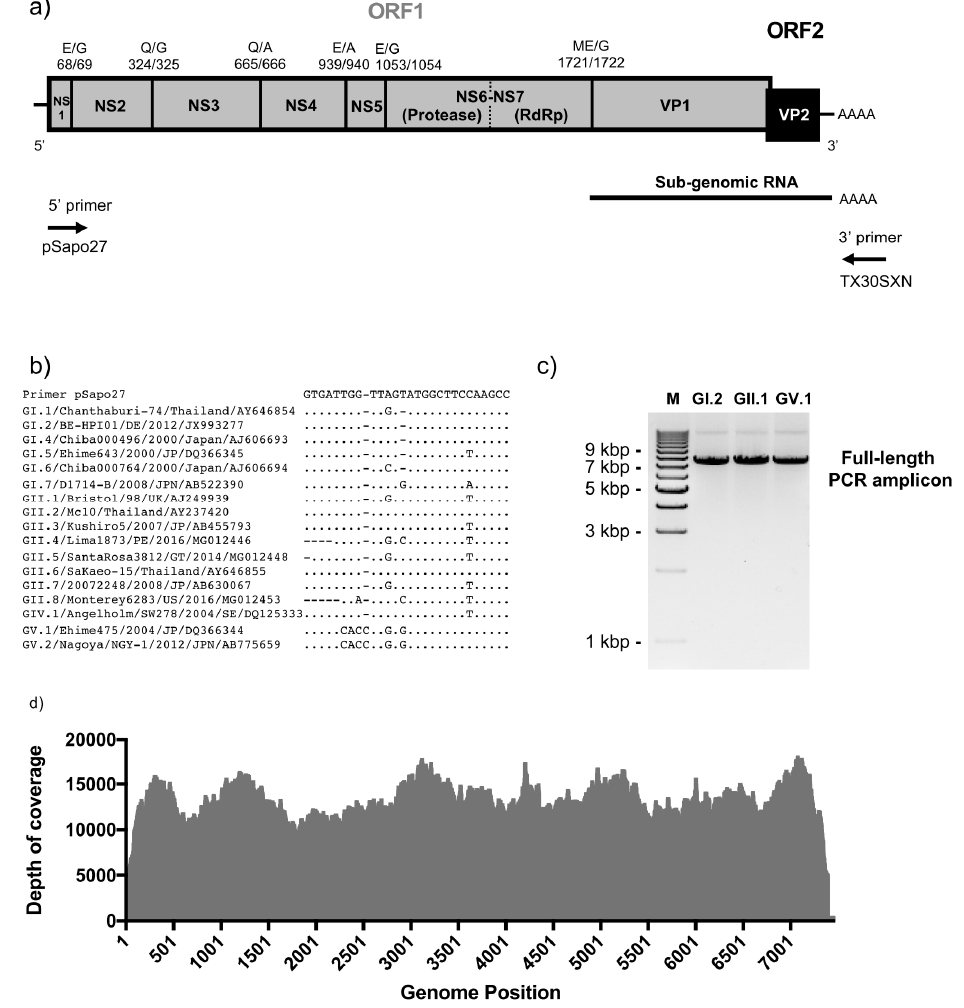
Figure 1. Full-length sapovirus genome PCR amplification and sequencing. ( a ) Sapovirus genome structure and primers pSapo27 and TX30SXN designed for one-step RT-PCR. Open reading frames (ORFs) and predicted cleavage sites are indicated on top. Amino acid positions are based on GI.1/Manchester/93 (X86560) strain ( b ) Alignment of 5’-primer (pSapo27) with human sapovirus genomes available in public repositories. ( c ) Agarose gel electrophoresis of full-length genome PCR amplicons of sapoviruses representing each of the genogroups GI, GII and GV. ( d ) Graph showing the depth of reads coverage in nearly-full length sapovirus genome sequences obtained from one of the archival samples (C102) in our study.